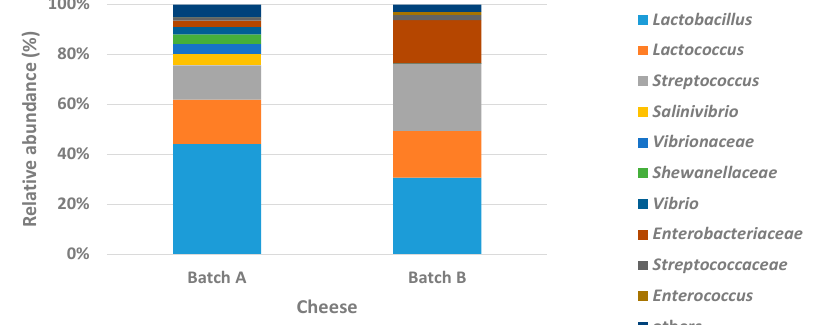
Figure 4. Abundances of bacterial genera detected on the two batches of cheese (relative abundance >1%) by next-generation sequencing. Family names are shown in the case that sequencing analysis succeeded only up to family level. The genera with relative abundances <1% are presented in the figure as “others”.